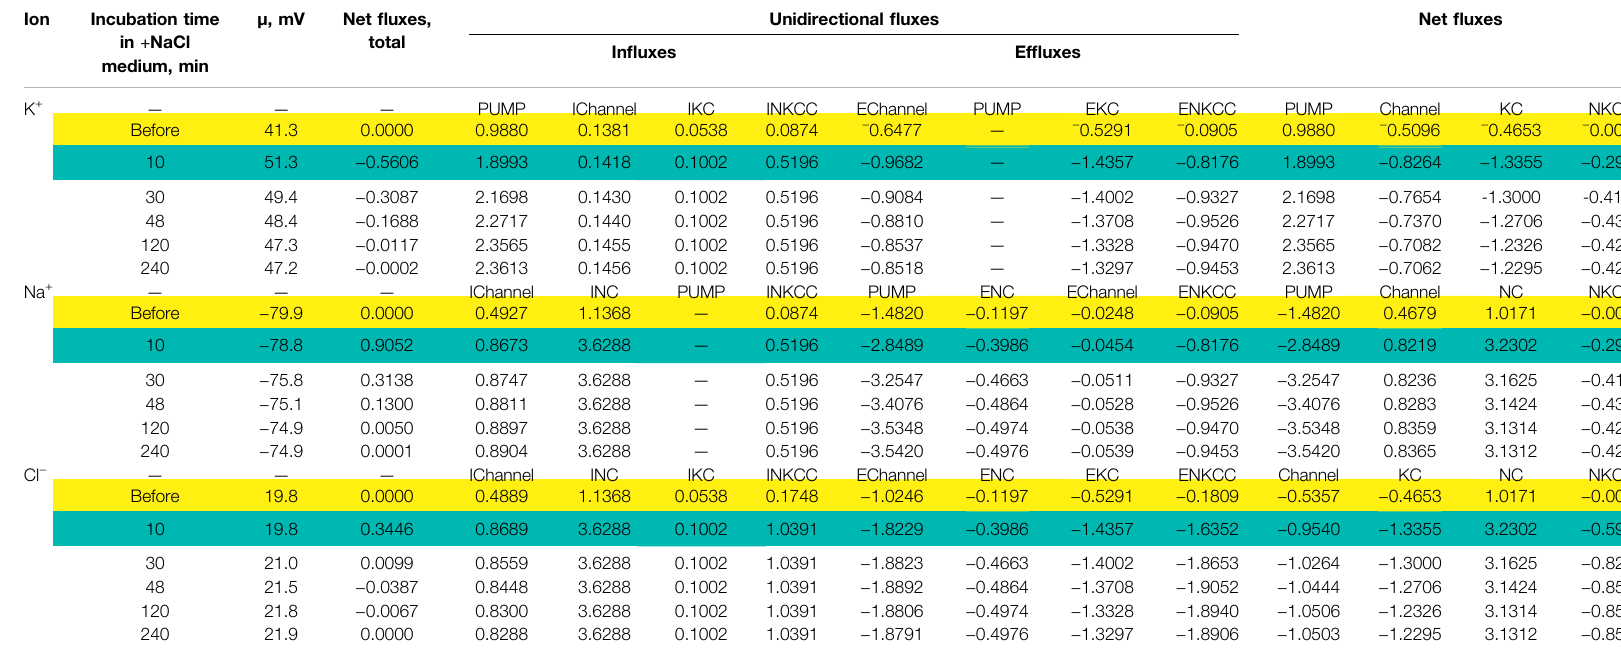
The “ Before ” lines,markedinyellow,representthebalancestateinanormalmedium.Thelinesmarkedingreenrepresenttheinitialvaluesinthehyperosmolarmedium.Parametersforthehypertonicmediumareasfollows,inmM:na0240,k0 5.8, cl0 216, B0 48.2; kv 1.645. Other parameters remain unchanged and given in Table 2